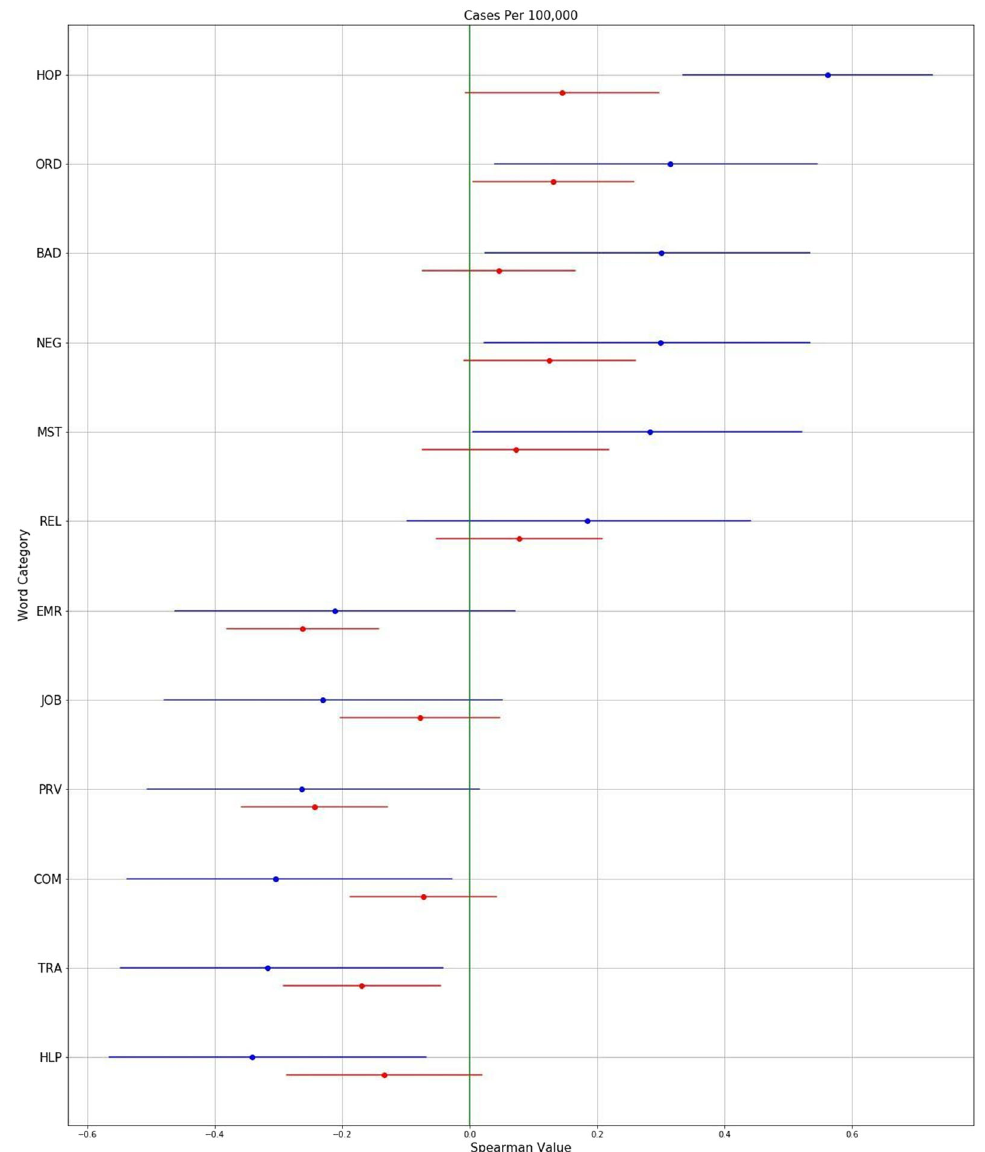
Fig. 1 Semantic categories associated with COVID-19 case rates. Semantic categories associated with Covid-19 case rates over both space and time. Average Spearman Rho correlations with 95% con fi dence intervals, calculated over both space (blue) and time (red). (HOP: Hospital- related; ORD: Strict instructions; BAD: Descriptive bad; NEG: Negation; MST: Extreme descriptive; REL: Religious; EMR: Emergency; JOB: Job- related; PRV: Preventative measures; COM: Formal communication; TRA: Travel-related; HLP: Help and